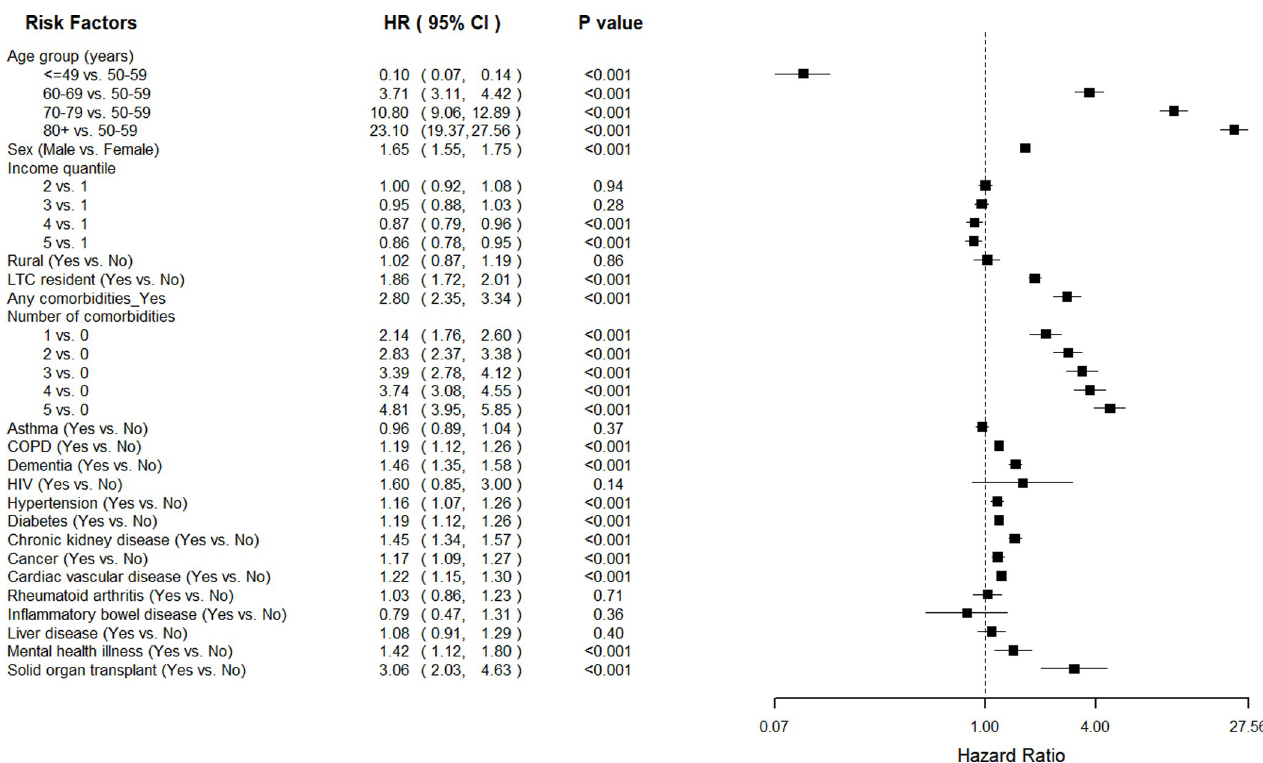
Fig 2. Associations of demo-socio-economic characters and comorbidities with 30-day all-cause mortality from Cox proportional hazard regression models. Lines represent 95% confidence interval. The hazard ratios of whether having any comorbidities, and number of comorbidities were calculated based on separate multivariable Cox models that included age, sex, income quantile, rural and LTC resident.